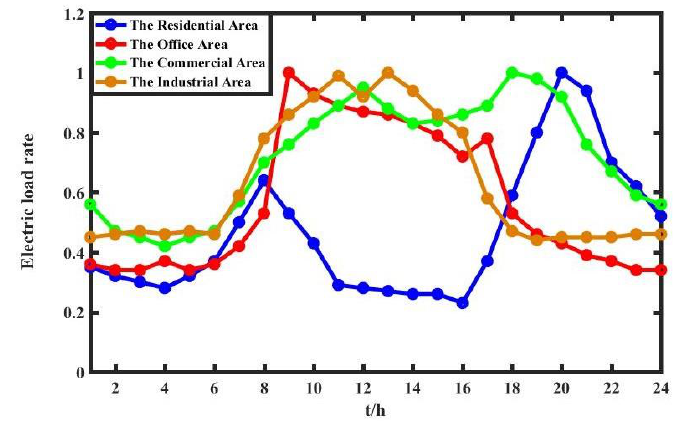
Figure 3. Typical electrical load rate curves of multiple functional areas.